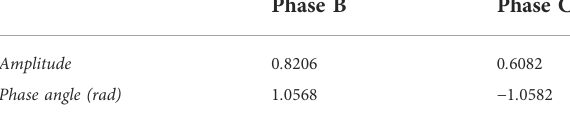
TABLE 4 Amplitudes and phase angles for the AC output voltage references of phases B and C.